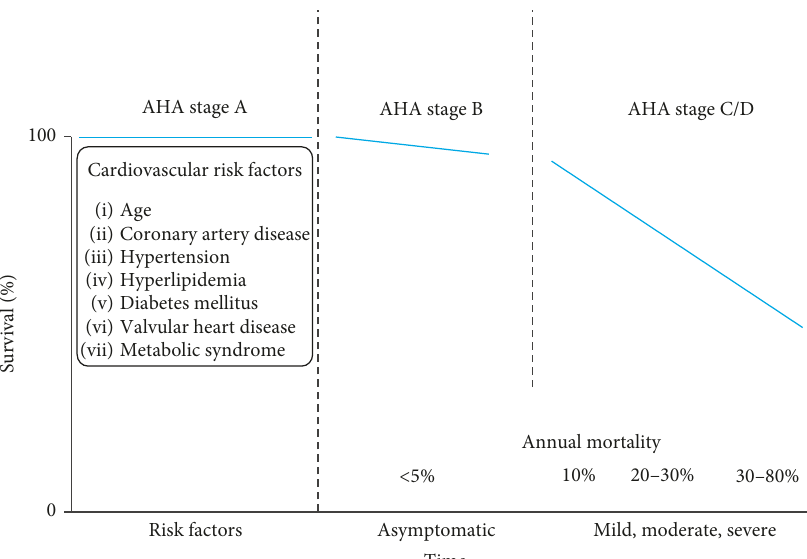
Figure 5: Correlation of AHA stage and survival. Note the marked deterioration in survival once the patient becomes symptomatic (the patient in the current case is AHA class C, mild to moderate with an annual mortality between ten and twenty percent) (adapted from Mayo Board Review, Figure 93.1 (page